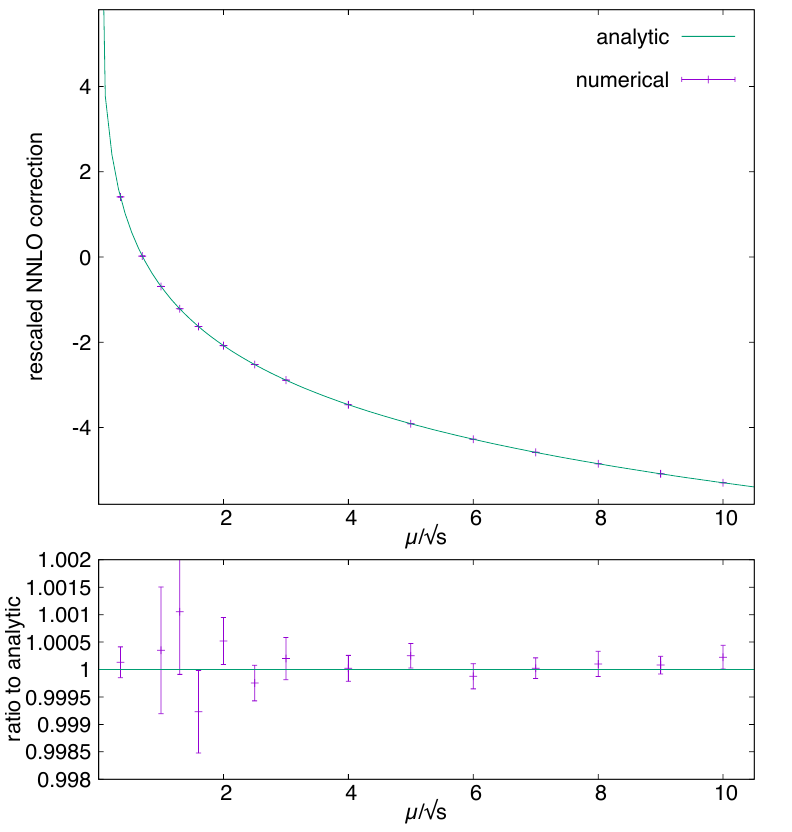
Figure 1 . Rescaled NNLO correction as a function of the renormalisation